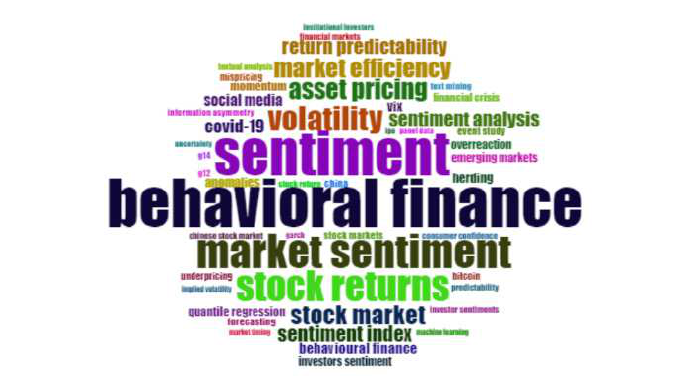
Figure 6. Word cloud analysis showing most frequently used